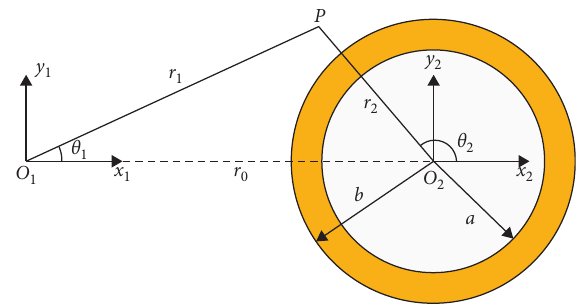
Figure 1: Incident cylindrical SH